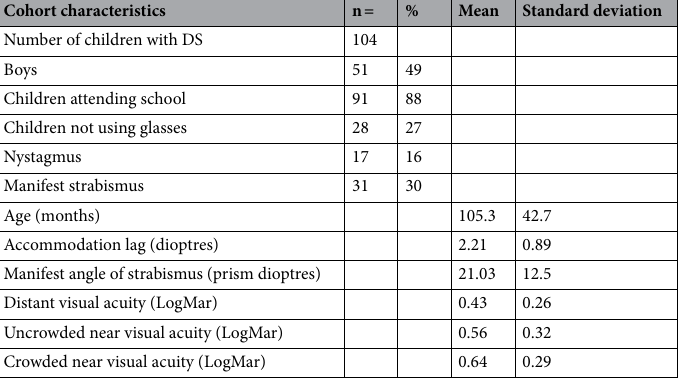
Table 2. Cohort characteristics. Data are given either as numbers (n =) and percentages (%) or as mean with standard